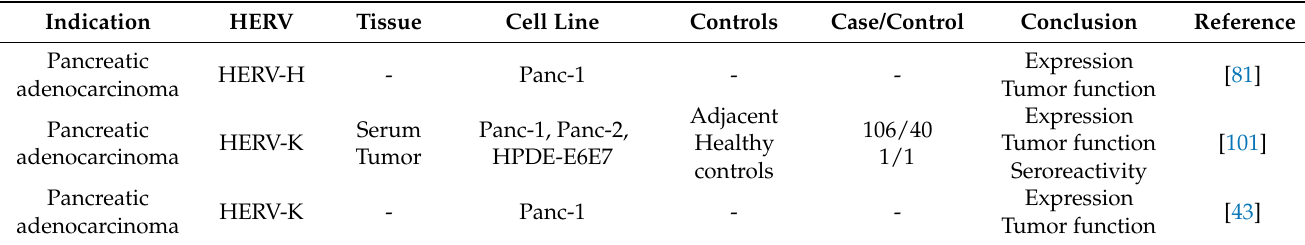
Table 11. HERV protein expression in pancreatic cancers.